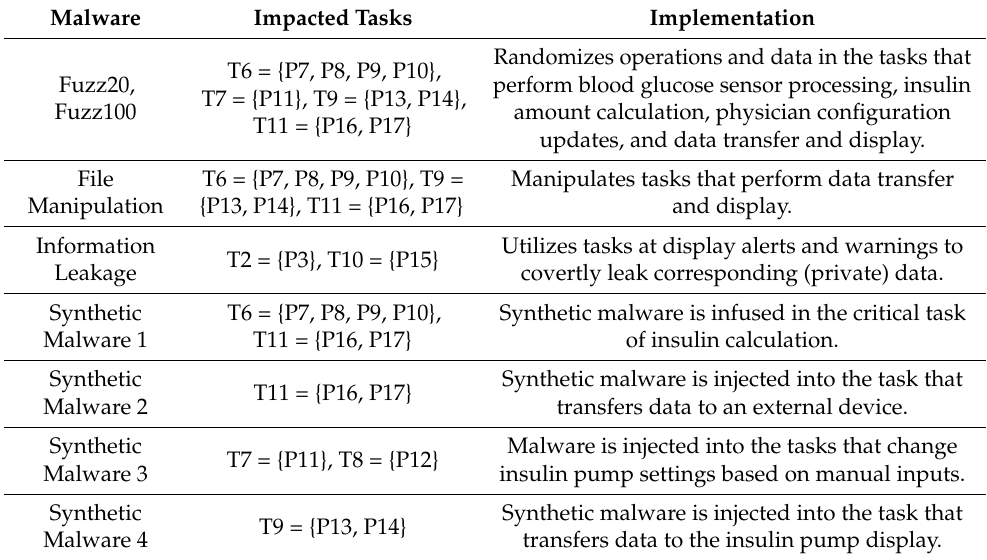
Figure 7. Overview of the experimental setup to simulate FIRE. Table 3. Malware